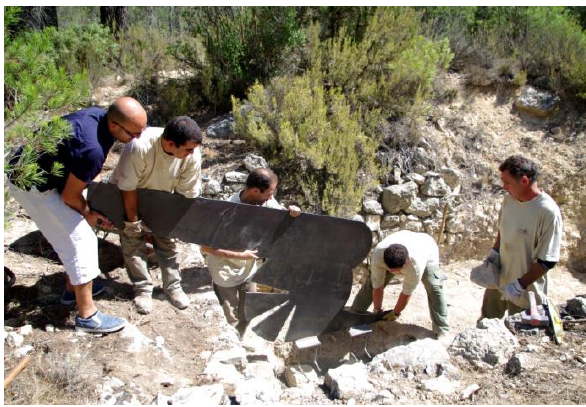
Figure 6. Unemployed people hired in the recovery of the trenches of Villargordo del Cabriel.